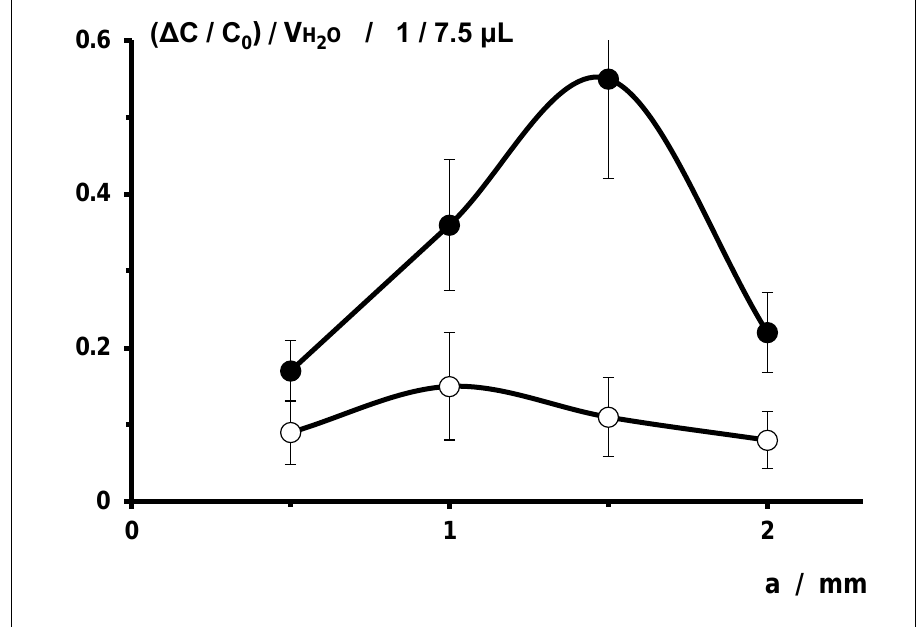
Figure 5. Relative water-specific change in electrical capacitance (ratio of the relative change in electrical capacitance to the causal change in water volume) (ΔC/C 0 )/V H2O of dressing samples in series S as a function of the sensor wire spacing a. Sensor wire diameter d = 0.071 mm; Stitching spacing; b = 1 mm—black, b = 3 mm—white.